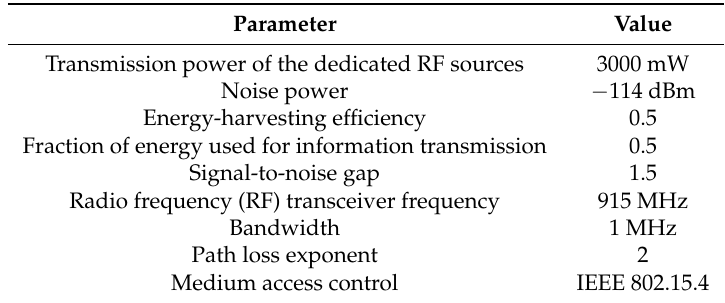
Table 1. Assumed simulation parameters.